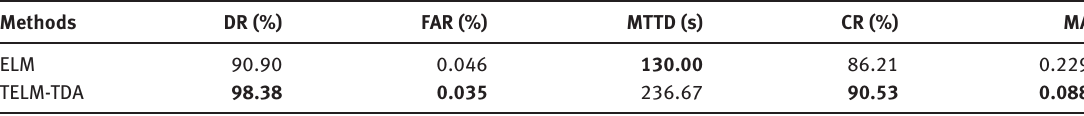
Table 4: Comparison between ELM and TELM-TDA in Terms of Indices of Performance and MAE.